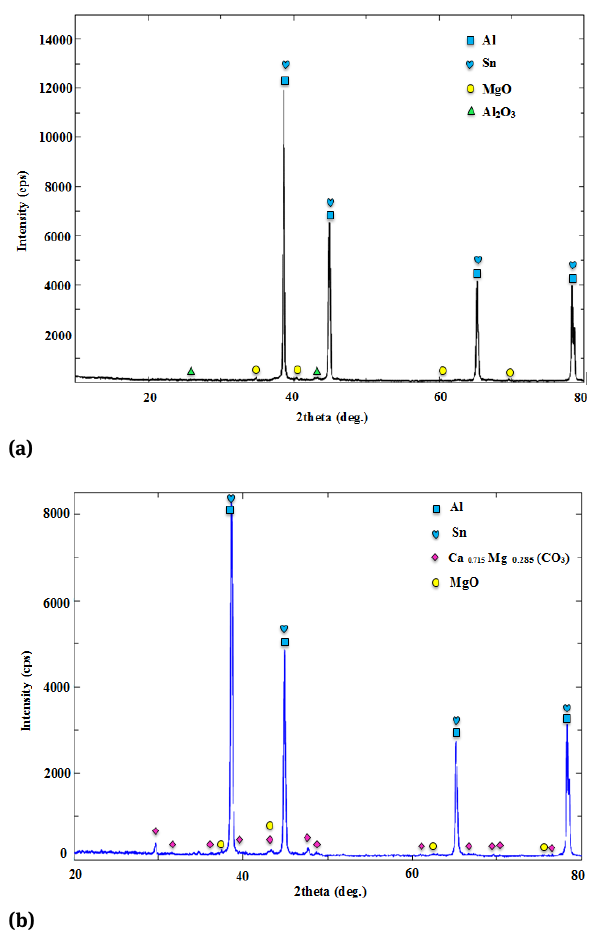
Figure 15: (a) XRD pattern of the base sample, Al-1.5Mg-1.5Sn, (b) XRD pattern of Al-1.5Mg-1.5Sn-6Es